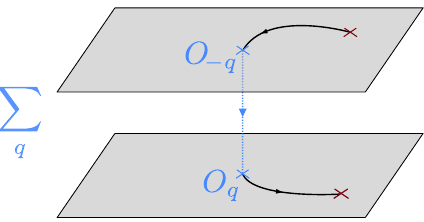
Figure 8 . We can reproduce the effects of the wormhole by an effective picture where we sum over correlated operators. This is also what happens from the boundary point of view, where the gravity region is replaced by a boundary condition which completely breaks the global symmetry. Here we are imagining that the operator insertions in the bath are far away from the gravity region. In some theories with a disorder average, the dashed blue line may represent a contraction of